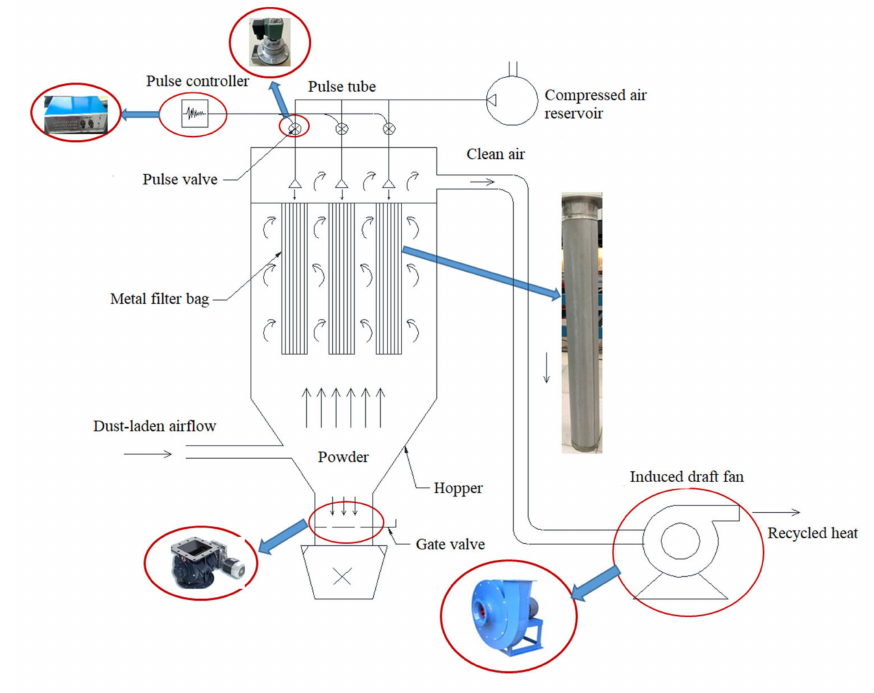
Figure 9. The metal filter bag system for purification of the high-velocity dust-laden